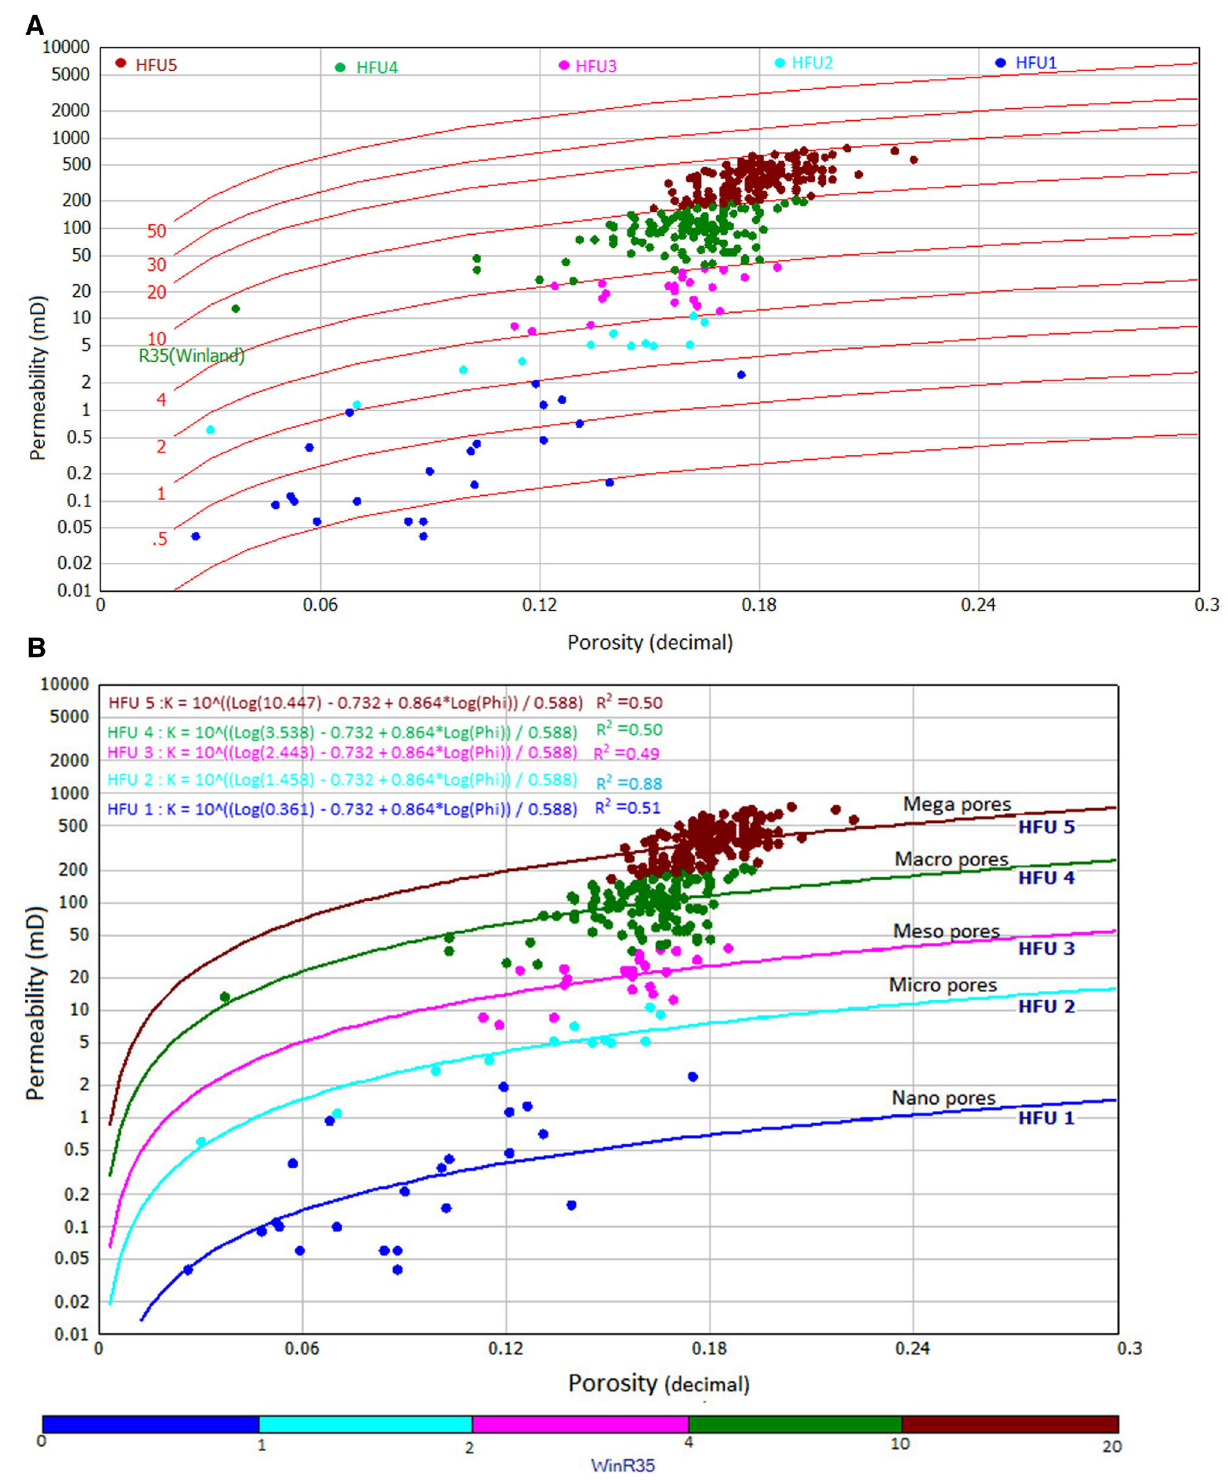
Figure 6. ( a ) Winland r35 pore throat radius for the identification of rock types, showing five different rock types from HFU 1 to HFU5. ( b ) Results of Winland r35 pore throat radius showing five different equations for rock types. ( c ) Superimposition of Winland r35 results on Lucia’s